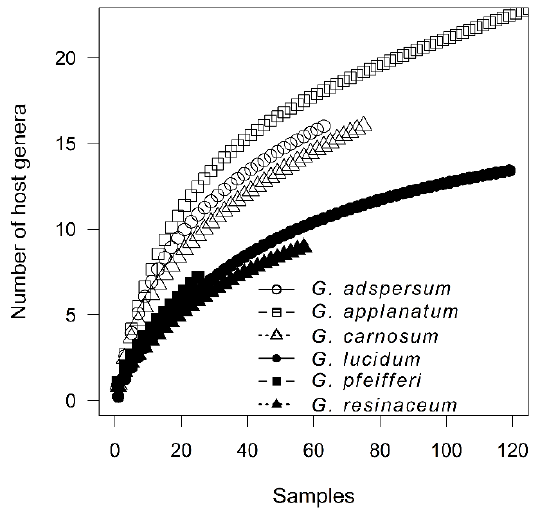
Figure 4. CCA analysis plot showing the differences in host tree composition among Ganoderma species and affiliation of them to host genera.